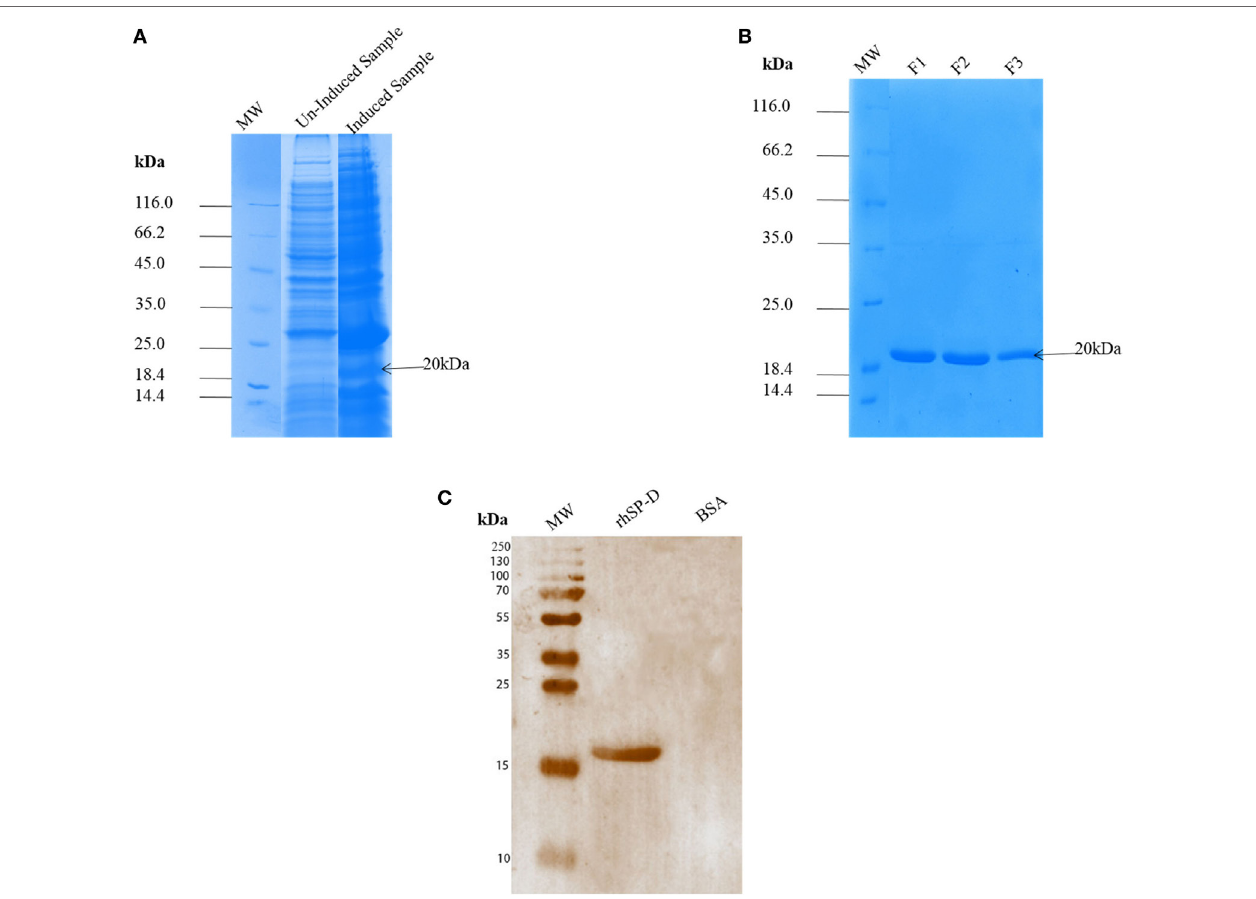
FigUre 1 | SDS-PAGE (12% v/v) under reducing conditions showing expression and purification of a recombinant surfactant protein D (rfhSP-D). The neck and carbohydrate recognition domain regions were expressed in Escherichia coli BL21 ( λ DE3) pLysS. (a) Following induction with 0.5 mM IPTG, a ~20 kDa band appeared being overexpressed compared to uninduced sample. Following denaturation–renaturation cycle, the rfhSP-D was purified on an affinity column to homogeneity after elution with EDTA as fractions F1, F2 and F3 (B) . A rabbit polyclonal antibody raised against full-length SP-D purified from human bronchoalveolar lavage (c) recognized the purified rfhSP-D, but not BSA that was used as a negative control